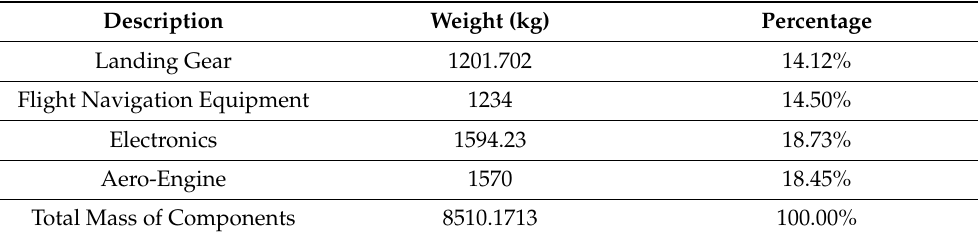
Table 1. Aircraft weight